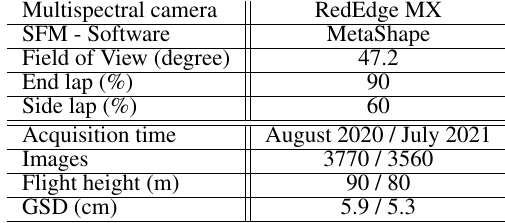
Table 2. Flight parameters of aerial image acquisition and software packages used.